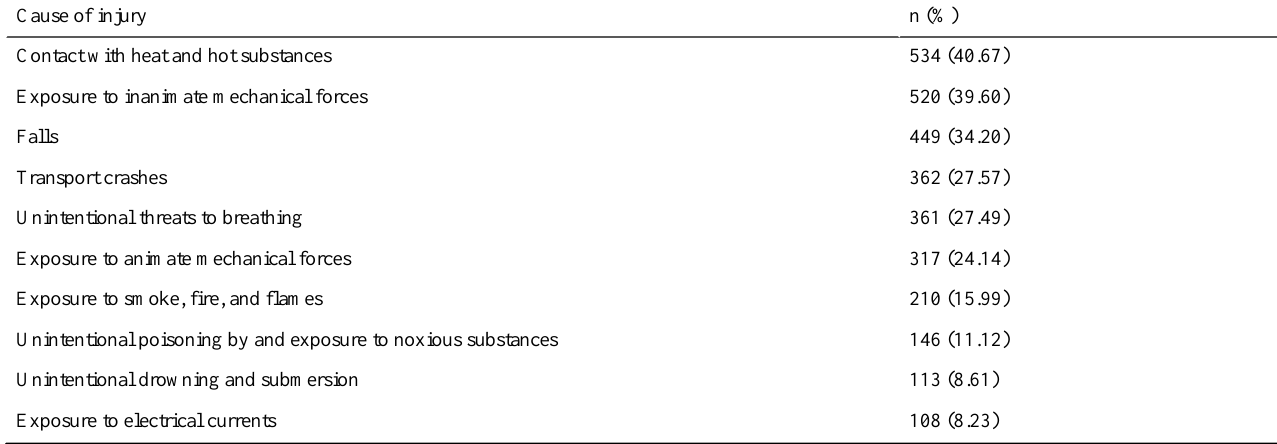
Table 2. Number of participants who expressed a desire to learn knowledge about preventing major types of child unintentional injury